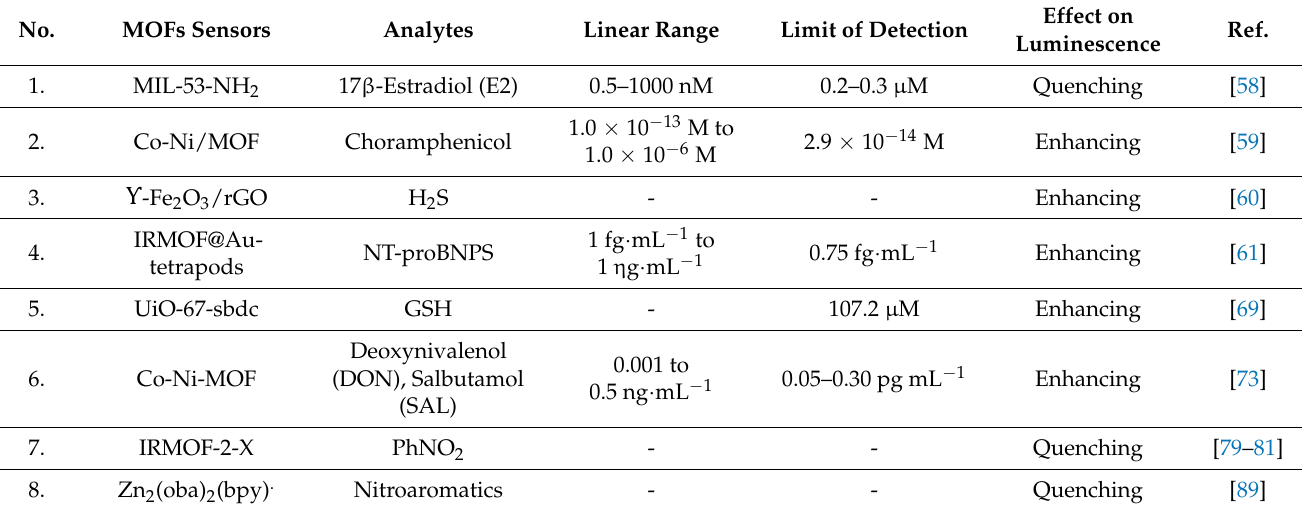
Table 1. Summary of metal–organic frameworks used for the detection of harmful substances.